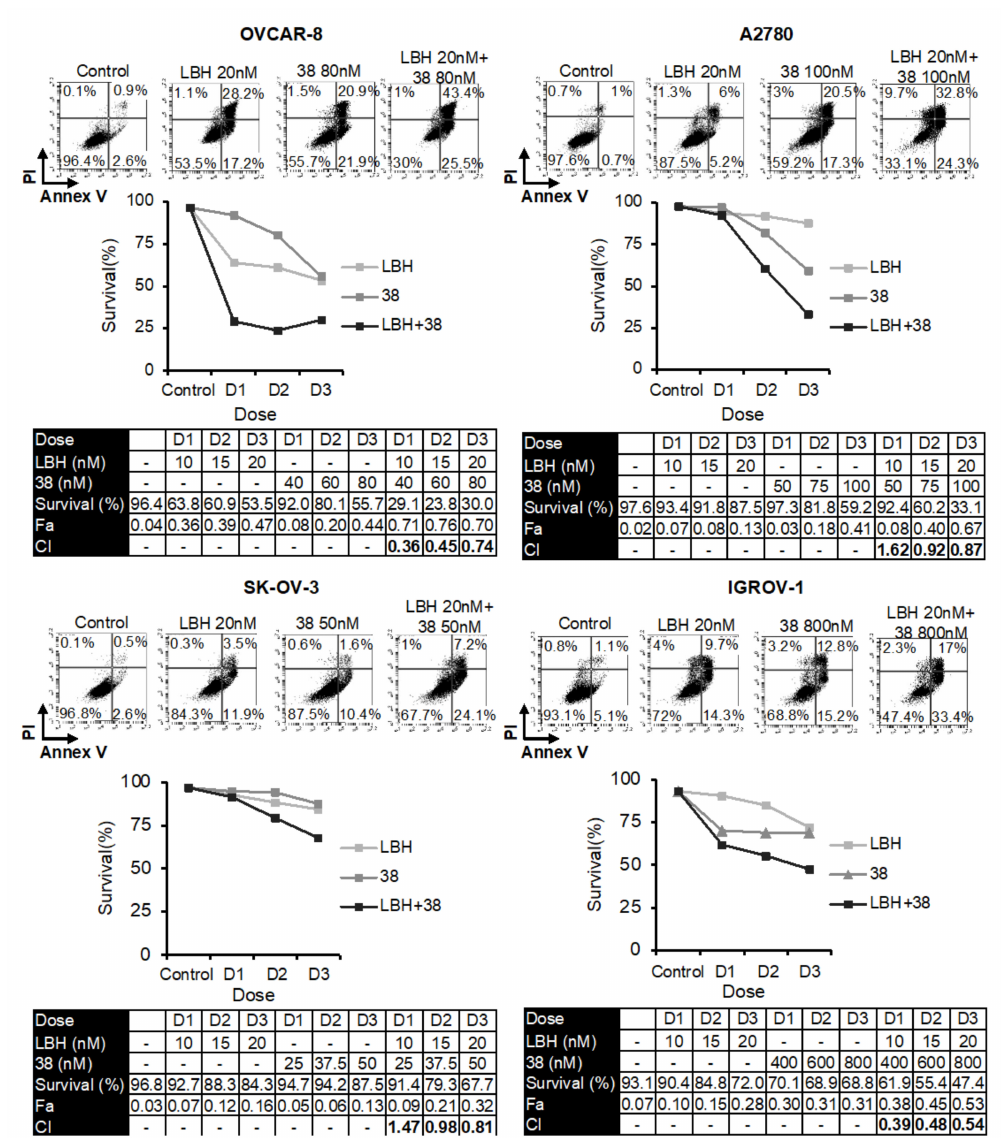
Figure 1. Synergistic effect of LBH and 38 in OCCLs. Cells were exposed for 72 h to the indicated concentrations of LBH and 38 at a constant ratio or vehicle control, and the percentage of apoptotic cells was assessed by flow cytometry (after cell staining with annexin V and propidium iodide). CI values, calculated using Compusyn Software, are